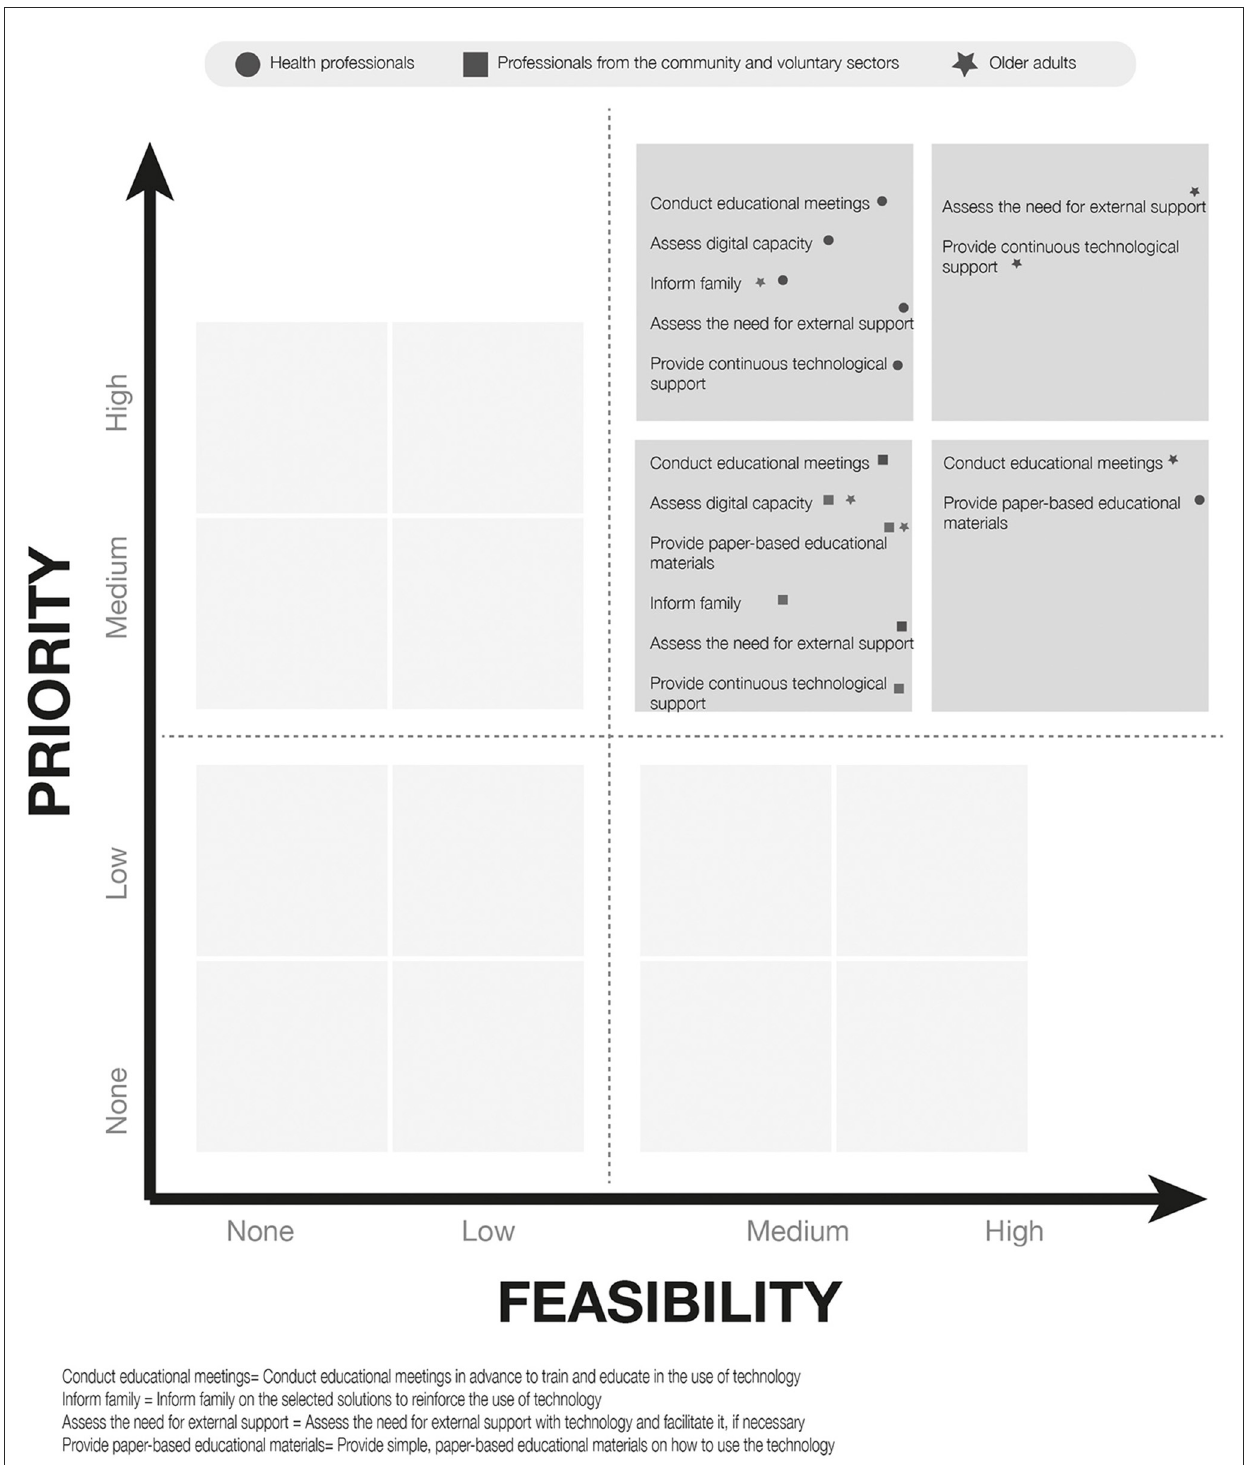
FIGURE1 Mapping of responses to general strategies to reduce digital barriers to older adults.